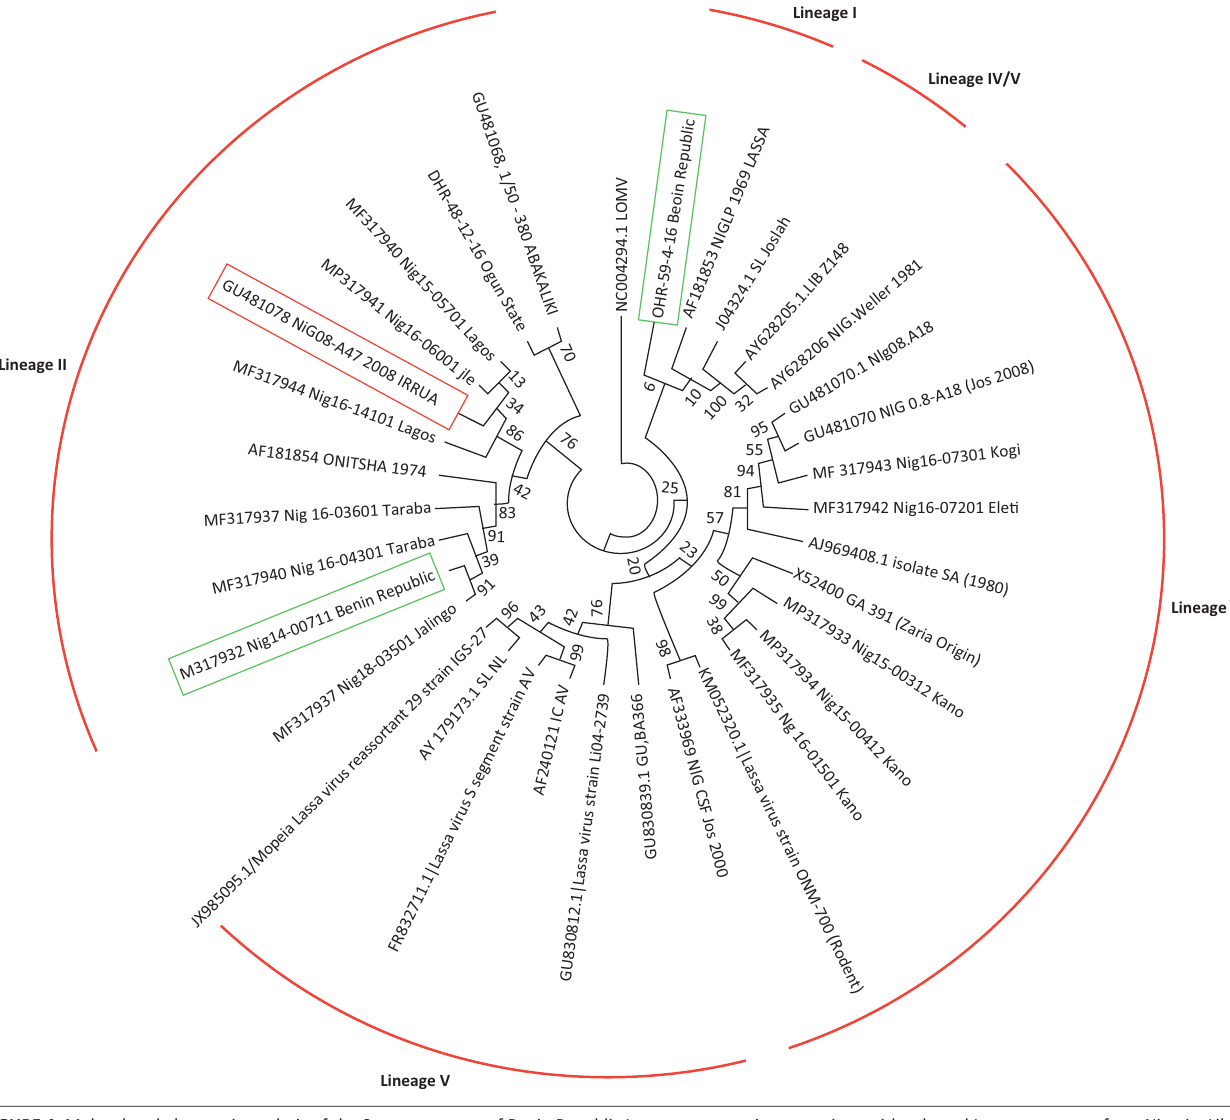
FIGURE 4: Molecular phylogenetic analysis of the S gene segment of Benin Republic Lassa sequences in comparison with selected Lassa sequences from Nigeria, Liberia and Sierra Leone by the maximum likelihood method, Lagos, Nigeria, March 2018. The numbers at the nodes are bootstrap values. Isolates in green boxes are from the Benin Republic. The isolate in the red box is the positive control of the assay. Lineage I covers the 1969 Lassa LP strain while Lineage II covers strains from Lagos, the eastern states of Nigeria such as the Onitsha strain in 1974, Abakaliki, Irrua, the middle belt and the few northeast central states in Nigeria; Lineage III covers the NIG-CSF-Jos 2000 strain, the western states and northwestern states strains such as GA392 in Zaria, Nigeria; Lineages IV/V cover the Josiah strain of Sierra Leone, and the Liberian